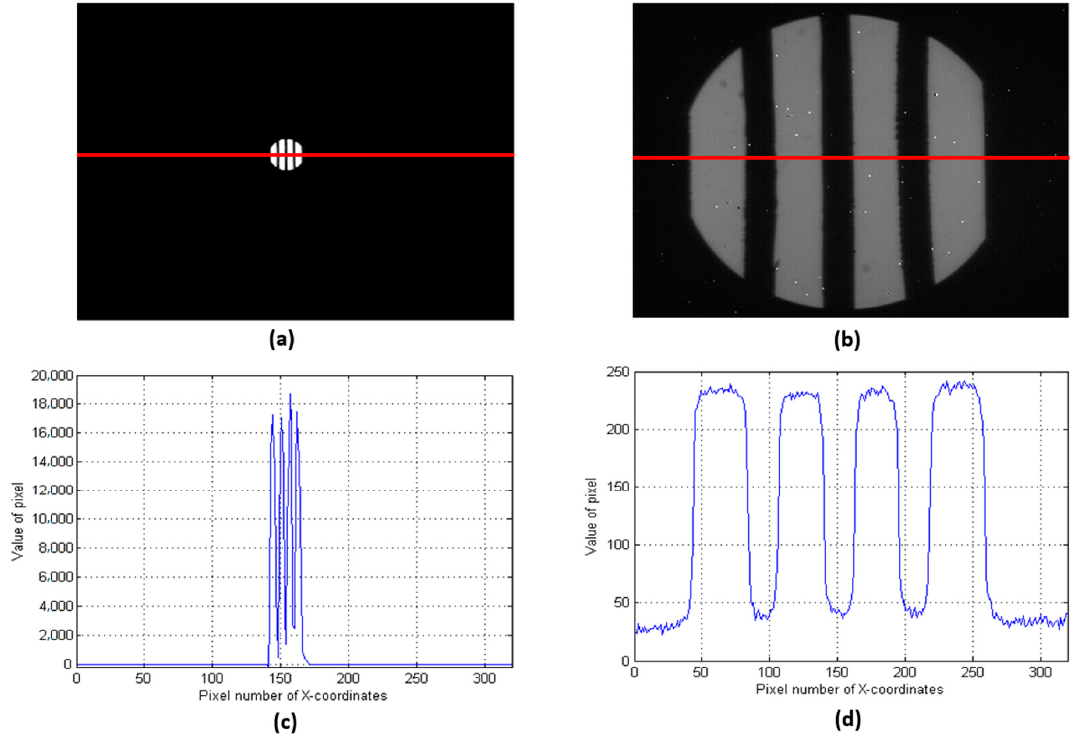
Figure 8. Images of strong light conditions. ( a ) Image acquired by the 8-mm lens, ( b ) image acquired by the 73-mm lens, ( c ) the row of data from the red line shown in ( a ), ( d ) the row of data from the red line shown in ( b ). The data here are the results of 16-bit quantization. For a better display, ( a , b ) are not shown in the same grayscale. The response of the 8-mm focus system was larger than that of the 73-mm focus system. However, the images from the 8-mm lens had a low resolution.